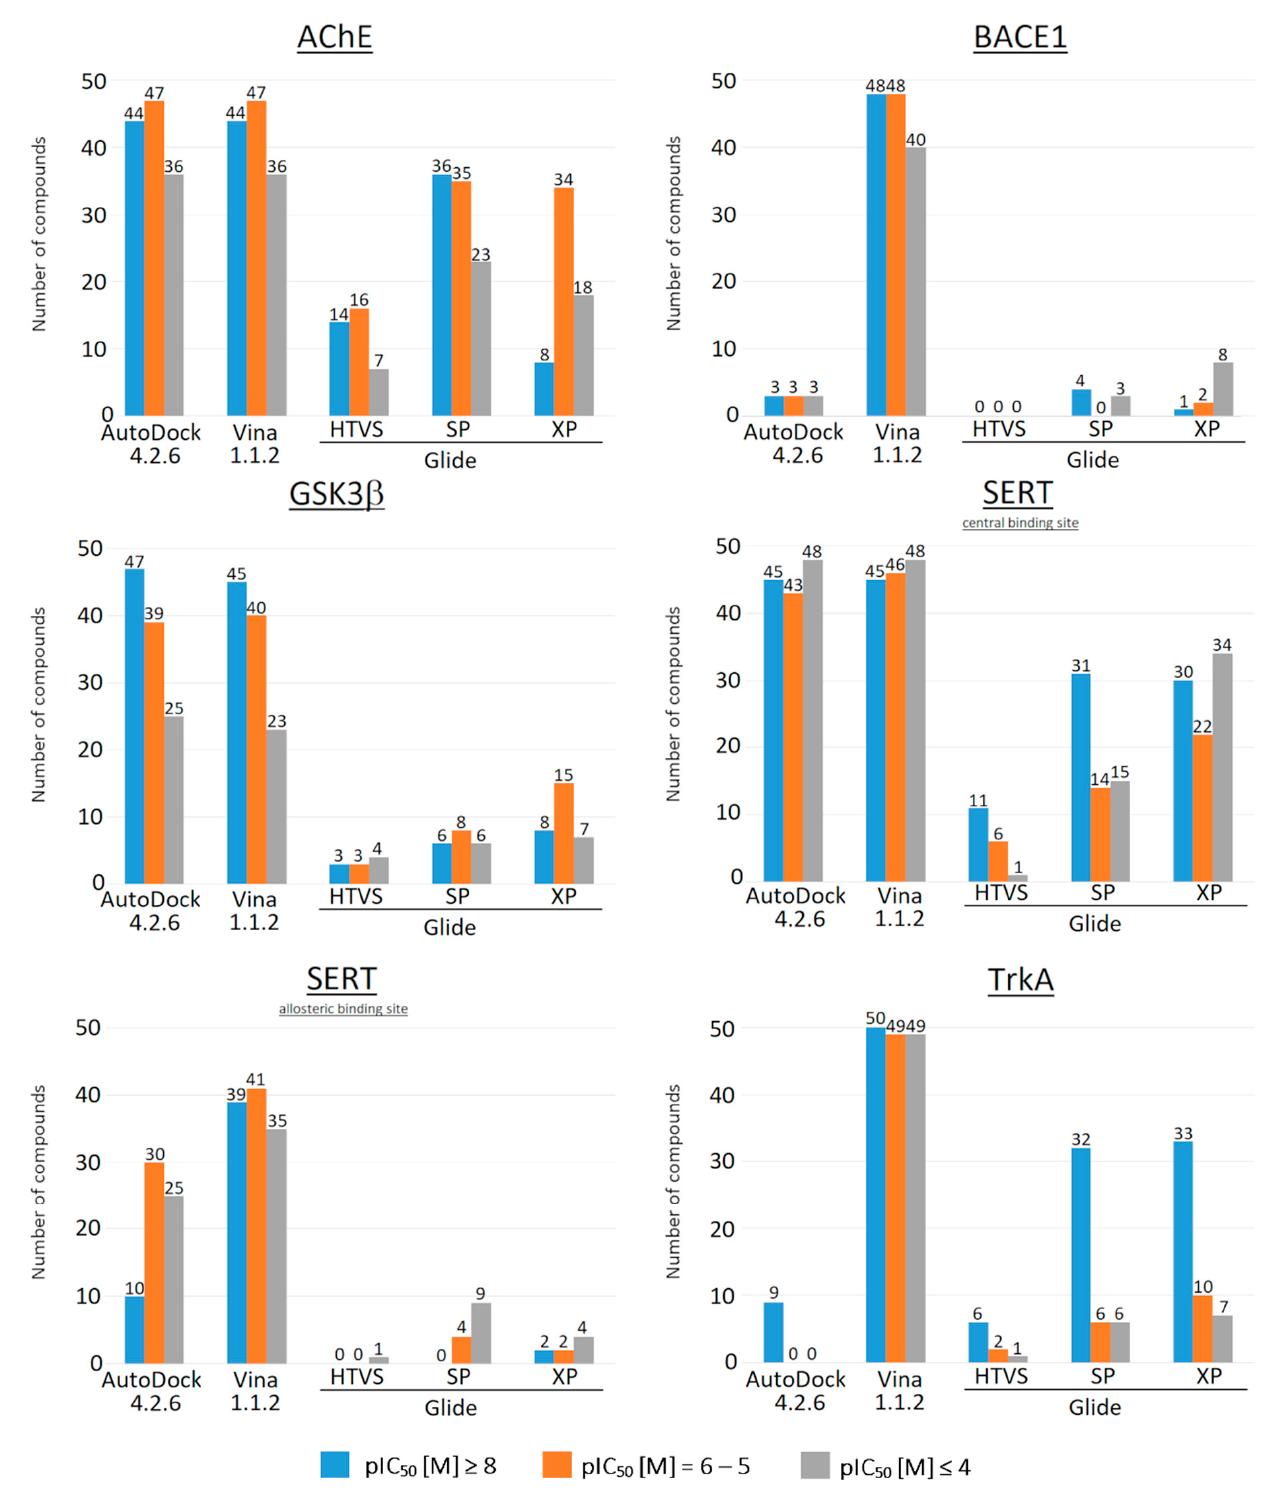
Figure 3. Number of compounds selected by ligand efficiency (LE ≥ 0.3) for all studied target pro- teins.